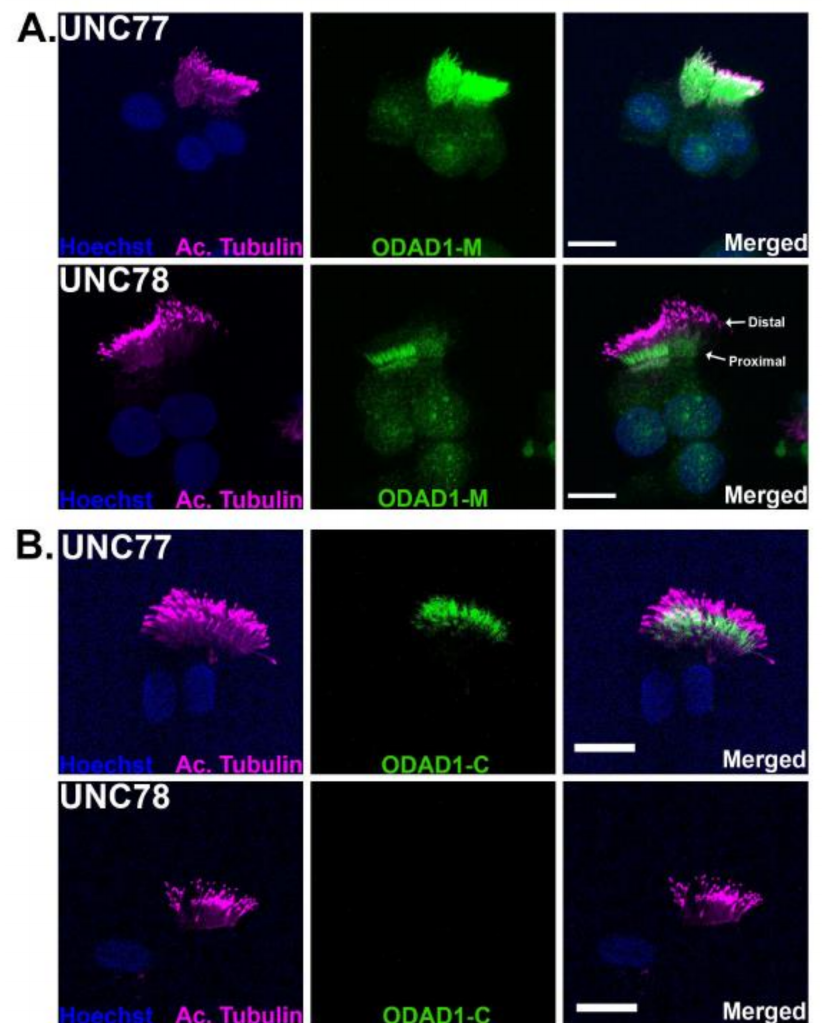
Figure 6. Immunostaining of ODAD1 . ( A ) Immunofluorescent staining of UNC77 with the antisera against the mid-region of ODAD1 shows strong positive staining throughout the cilia. In contrast, staining of UNC78 shows a weaker signal, mostly localized to the proximal region of the axoneme. ( B ) Staining with the antisera against the C-terminal region of ODAD1 shows a clear signal in the UNC77 cells, but no detectable staining in UNC78. Cilia were labeled with an antibody against acetylated tubulin. These results confirm the presence of truncated ODAD1 in the axonemes. Scale bars = 10 µ m. ( n = 2–3